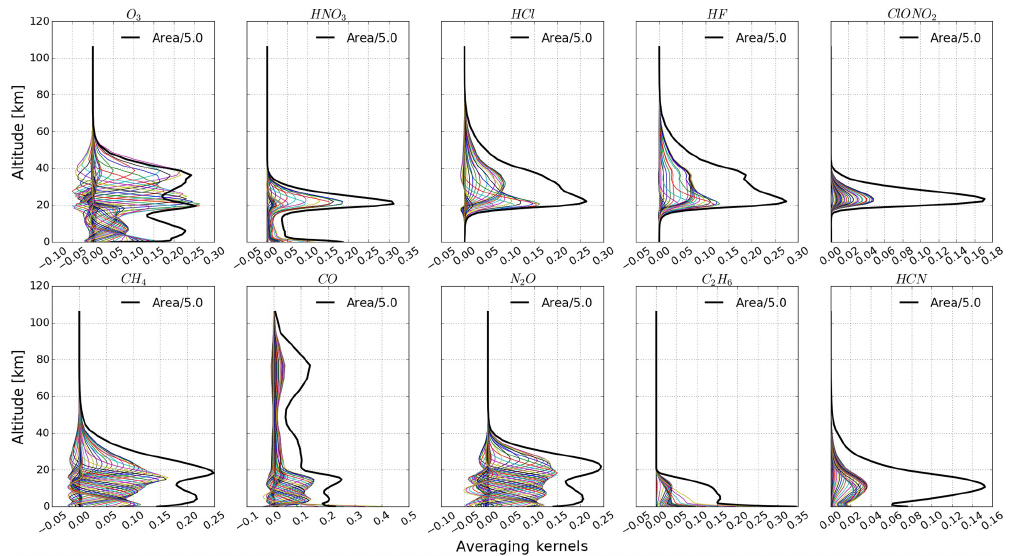
Figure 4. Averaging kernels of 10 NDACC gases (coloured fine lines) and their area scaled by a factor of 0.2 (black bold line). They are deduced from the spectra recorded at Hefei on 16 February 2016 with an ideal